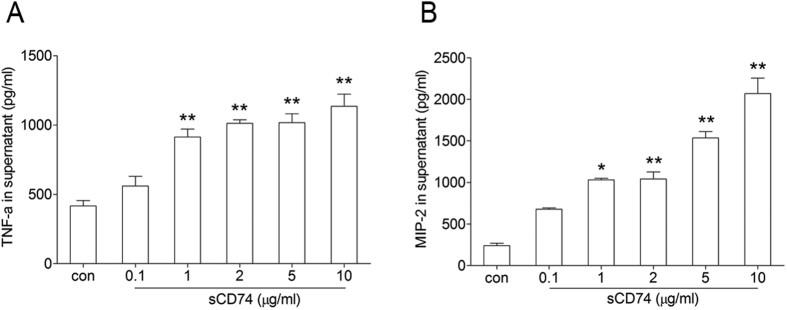
Effect of sCD74 on RAW264.7 cells.RAW264.7 cells were treated with different concentrations of sCD74 (0.1, 1, 2, 5, 10 μg/ml) or control media for 24 hrs. After 24 hrs supernatants were collected and TNF-α (A) and MIP-2 (B) concentrations were measured by ELISA. Bar graphs represent the mean ± SEM of three independent experiments. *P < 0.05 and **P < 0.01 compared to control with Dunnett-t test after ANOVA for multiple comparisons.